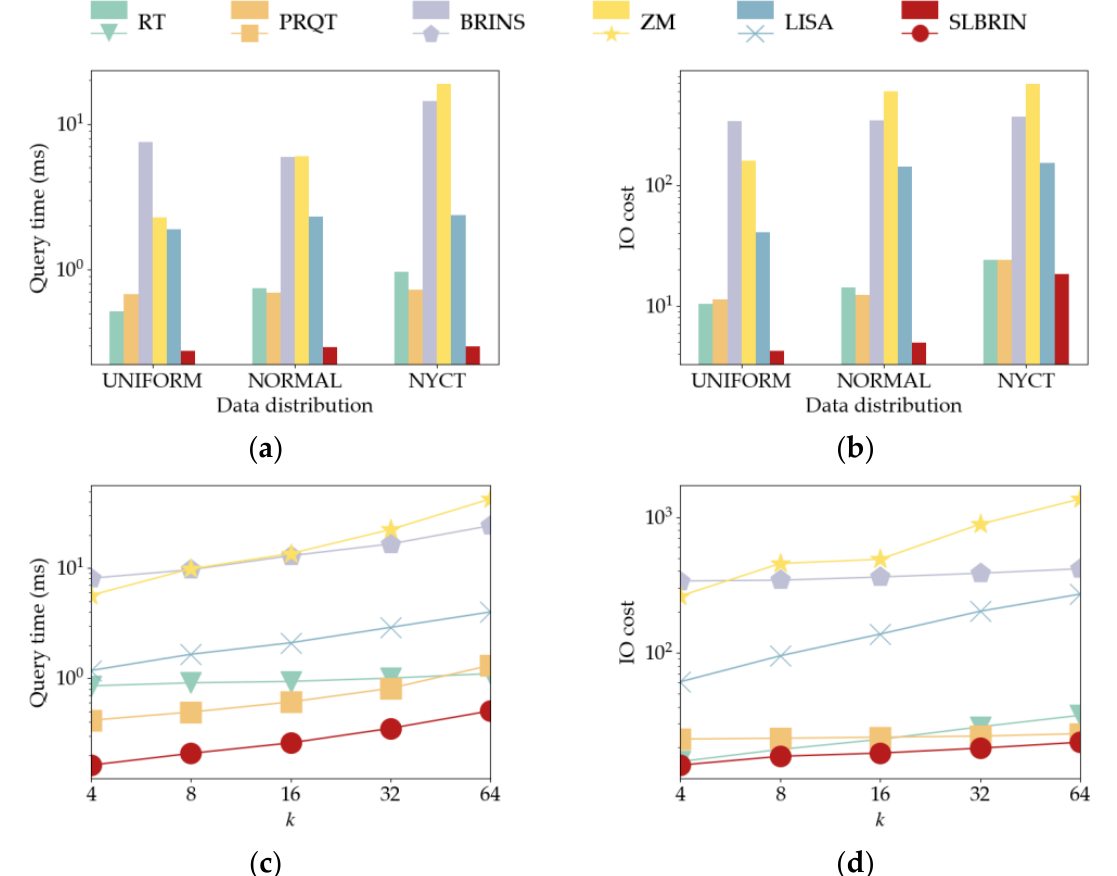
Figure 8. k NN query performance. ( a , b ) Vs. data distribution. ( c , d ) Vs. k on NYCT.